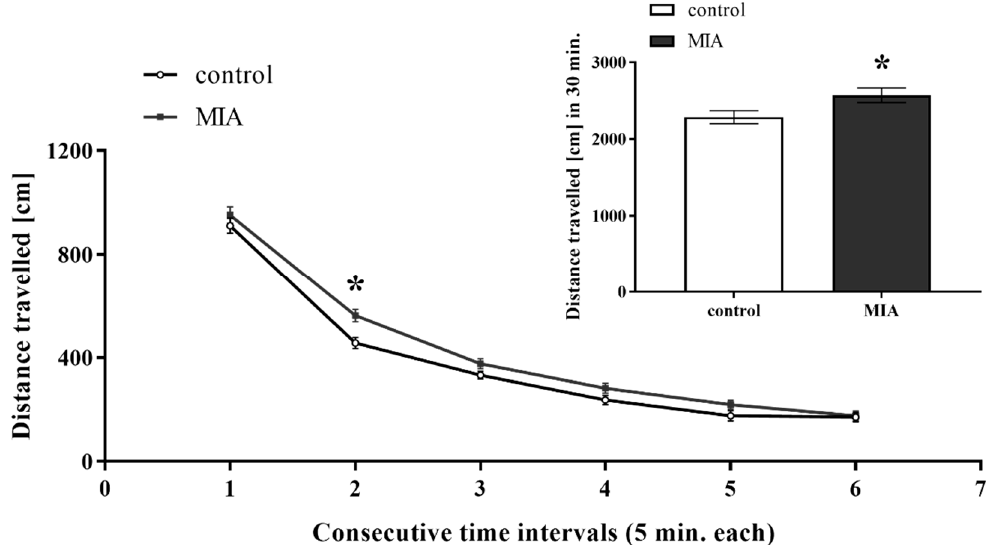
Figure 2. The effect of MIA on the exploratory activity of adult male Sprague-Dawley offspring. The exploratory activity is expressed as a distance travelled (in cm) in respective time intervals (5 min each) and the total distance travelled during 30-min-interval (showed on the inset). n = 42 in the control group, n = 69 in the MIA group. The results are presented as the means ± SEM. * p < 0.05 vs. control group.